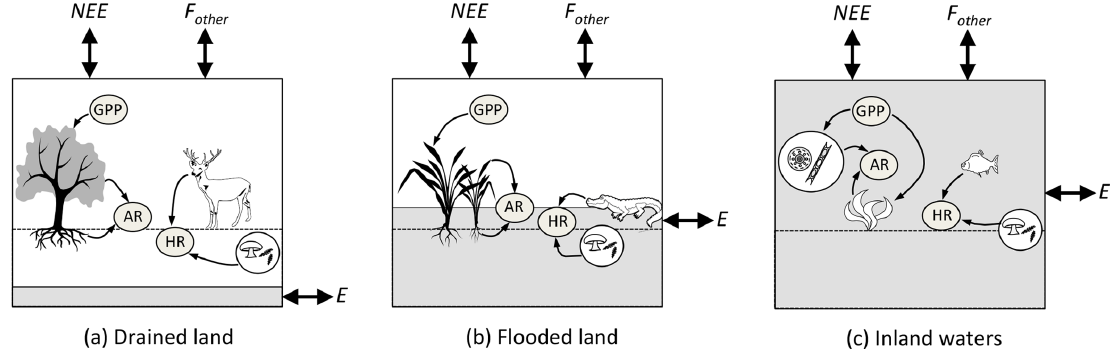
Figure 2. Relationship among the carbon (C) fluxes (in italics) that determine net ecosystem carbon balance (NECB) (the net of all C imports to and exports from the ecosystem), as well as the metabolic fluxes (inside grey oval) that determine net ecosystem production (NEP). (Adapted from Chapin III et al., 2006, to include aquatic compartments.) The boxes represent the ecosystems: (a) drained land, (b) flooded land and (c) inland waters. Fluxes contributing to NECB are net ecosystem exchange (NEE) with the atmosphere (emissions to or uptake from the atmosphere of carbon dioxide, CO 2 ); fluxes of carbon forms other than CO 2 ( F other ), which include methane (CH 4 ), carbon monoxide (CO) and volatile organic C (VOC); lateral export ( E ) or import of dissolved organic and inorganic C and particulate organic C by hydrological transport and other processes such as animal movement, wind deposition and erosion, and anthropogenic transport or harvest. In this study, we consider F other as the flux of CH 4 from the ecosystem to the atmosphere and E as hydrological export from the ecosystem as POC, DOC, dissolved CO 2 and dissolved CH 4 . Fluxes contributing to NEP are gross primary production (GPP) and ecosystem respiration (ER). ER includes autotrophic respiration (AR) by the different components of vegetation (leaves, wood, roots and photosynthetic microbes) and heterotrophic respiration (HR) by prokaryotes, fungi and animals. The shaded volume in each box indicates the part of the ecosystem occupied by water. GPP and ER occur mostly above the water table in well-drained ecosystems, partly above and below the water table in flooded ecosystems, and exclusively in water and sediments in aquatic